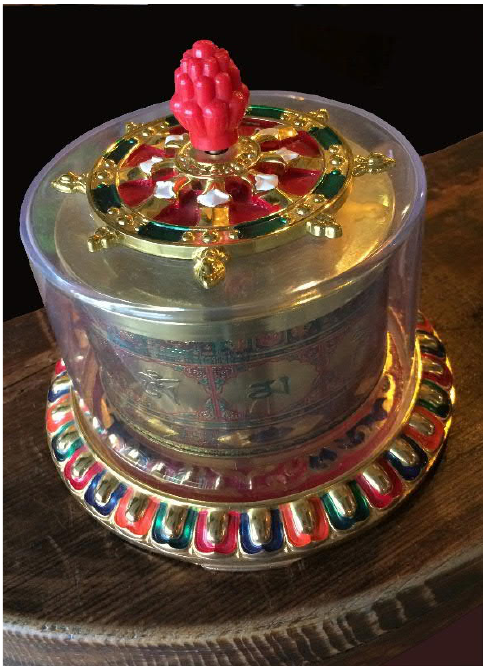
Figure 5. Norbu’s prayer